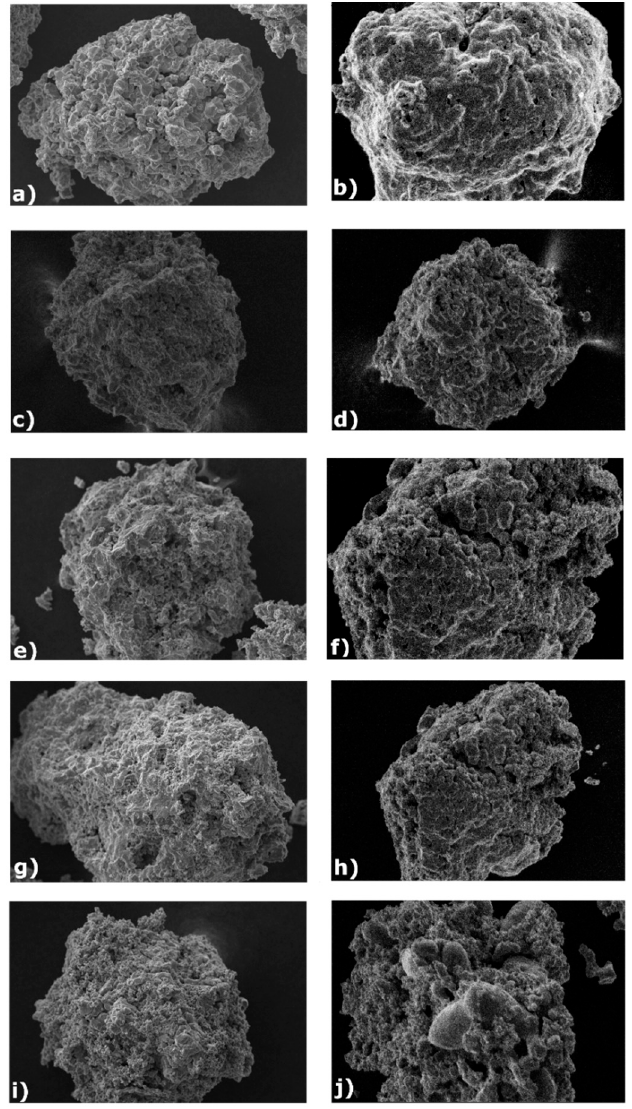
Figure 8. Morphology comparison of fresh (left column) and reacted (right column) oxygen carrier samples. SEM photomicrograph taken at x500 magnification for F20M65 ( a,b ), F30M55 ( c,d ), F35M50 ( e,f ) F50M35 ( g,h ) and M85 ( i , j ).